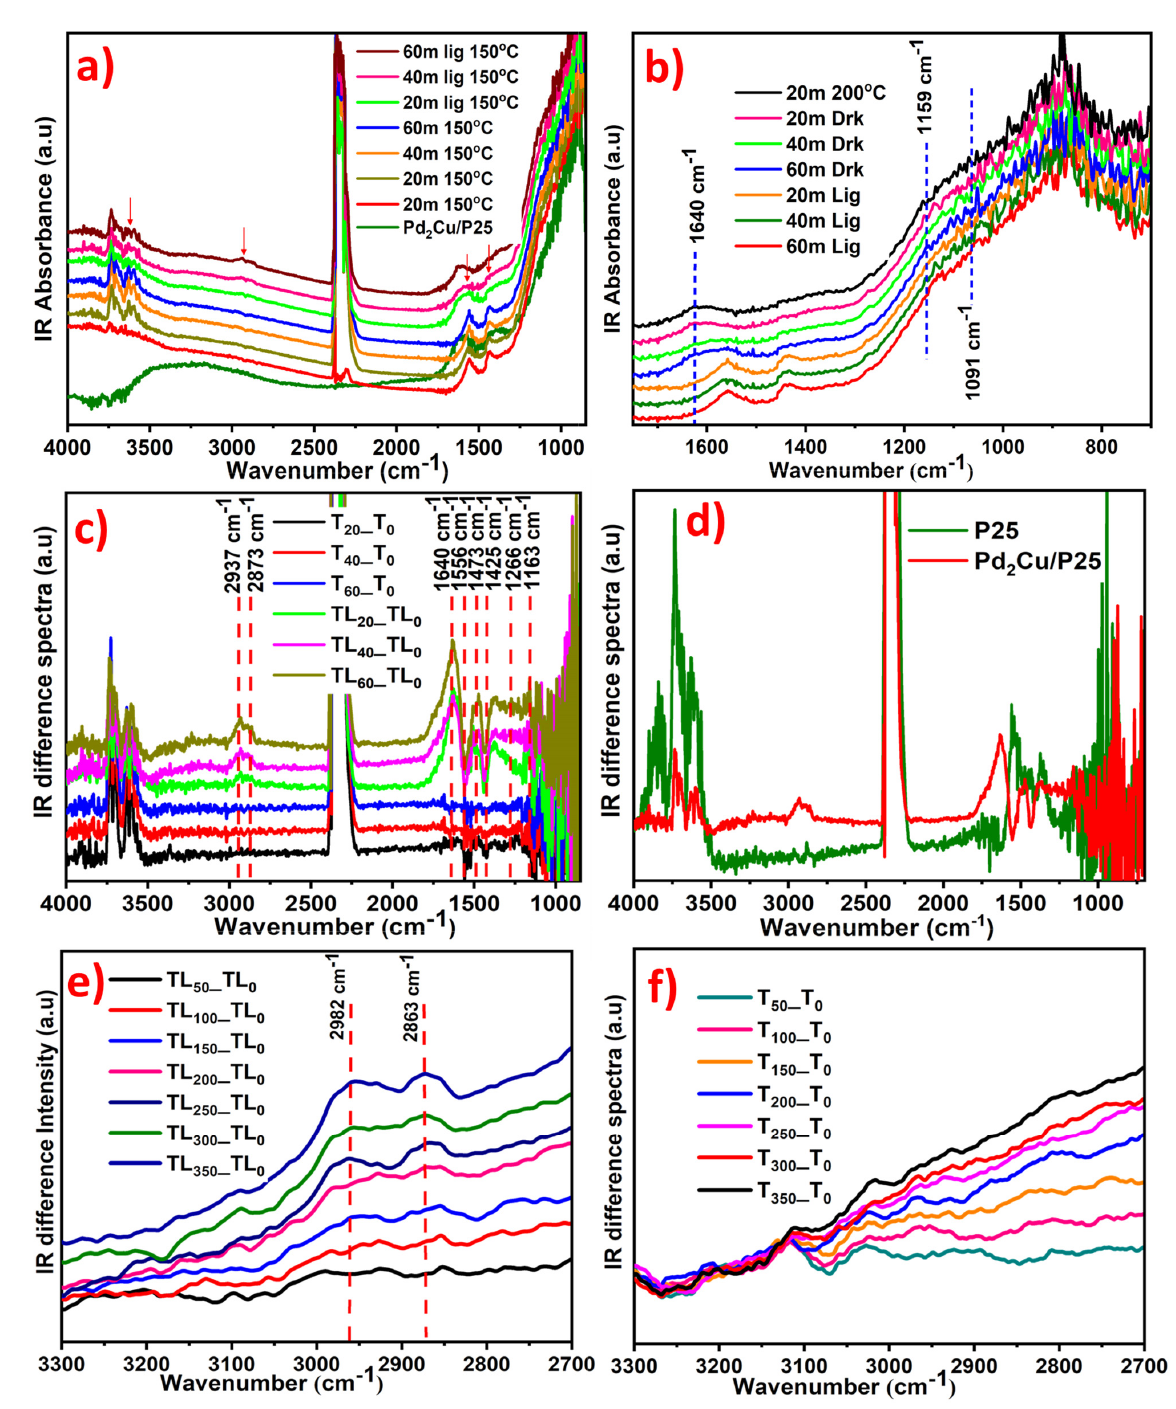
Figure 6. ( a , b ) Time-dependent DRIFT spectra of Pd 2 Cu/P25 and ( c ) IR difference spectra of CO 2 reduction on Pd 2 Cu/P25. ( d ) IR difference spectra of P25 and Pd 2 Cu/P25 after 1 h light irradiation. DRIFT spectra CO 2 reduction on Pd 2 Cu/P25 at various temperatures ( e ) with and ( f ) without light irradiation.